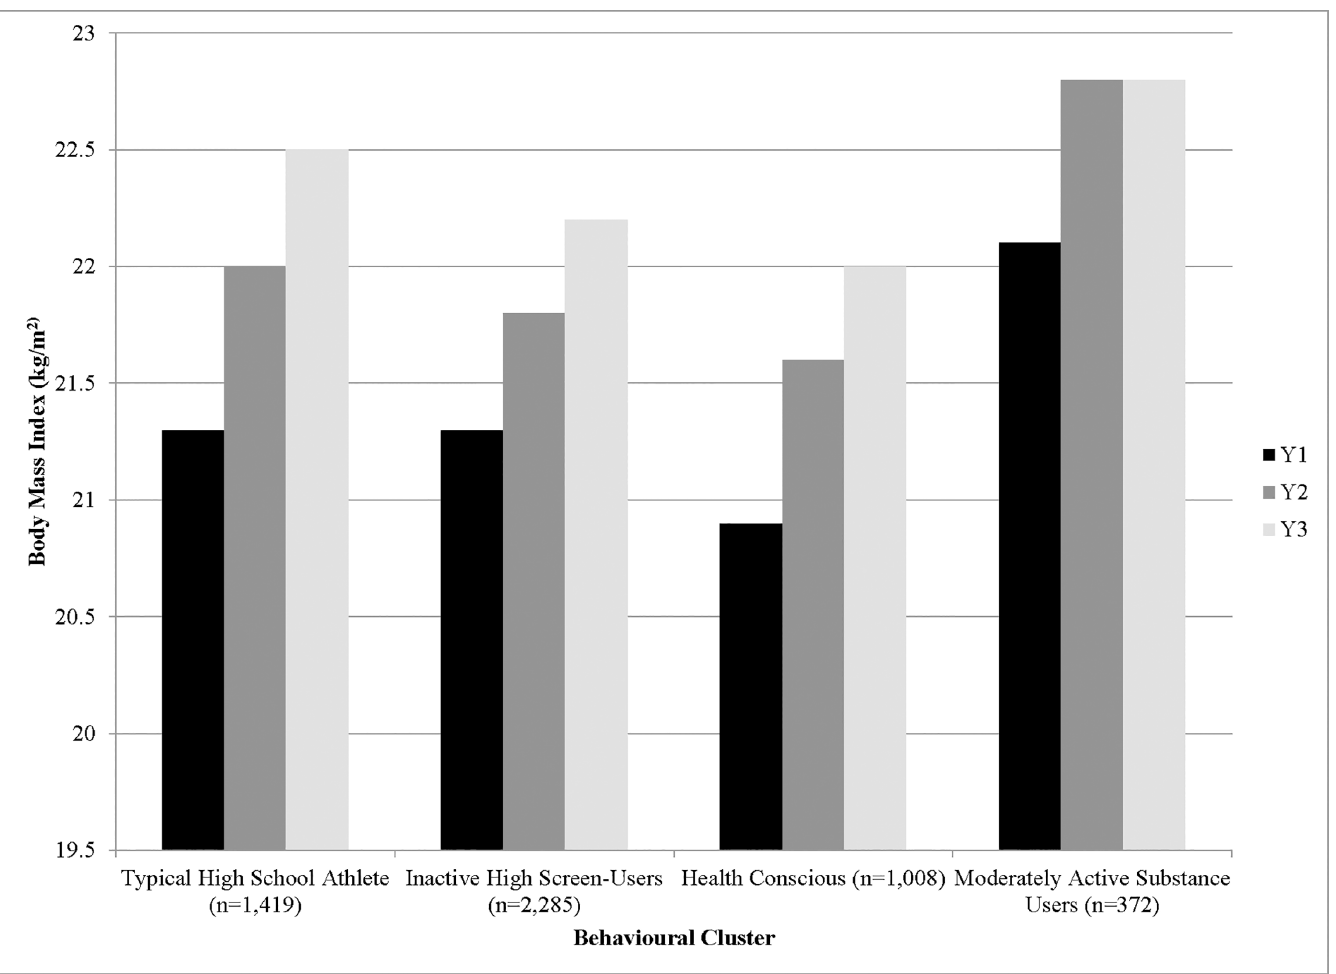
Fig 2. Averageannual changes in BMI from the sample participating in Y 1 to Y 3 of the COMPASS study in Ontario, Canada.